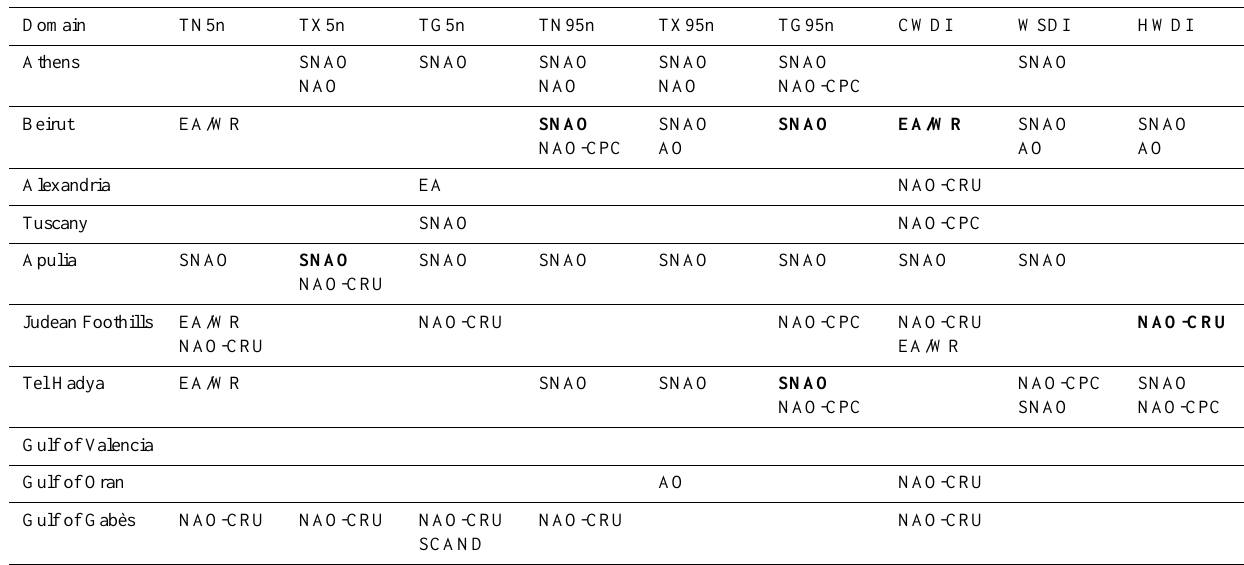
Table 8. Relationships between indices of temperature extremes and large-scale atmospheric circulation indices, as in Table 6, but for summer (JJA).